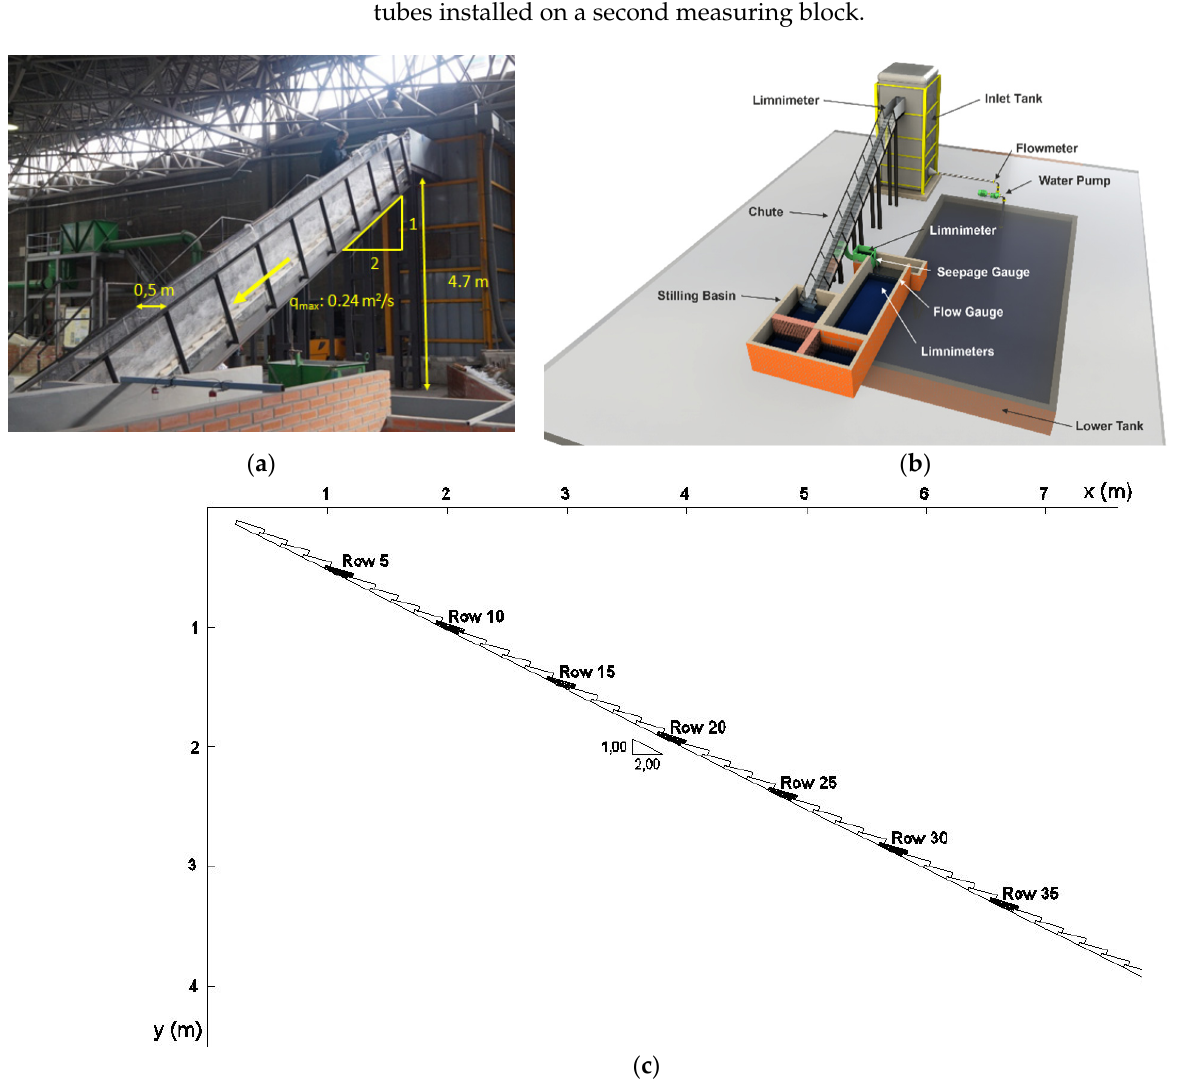
Figure 3. The experimental setup: ( a ) a photo of the testing facility, ( b ) scheme and ( c ) a pthe instrumented rows.